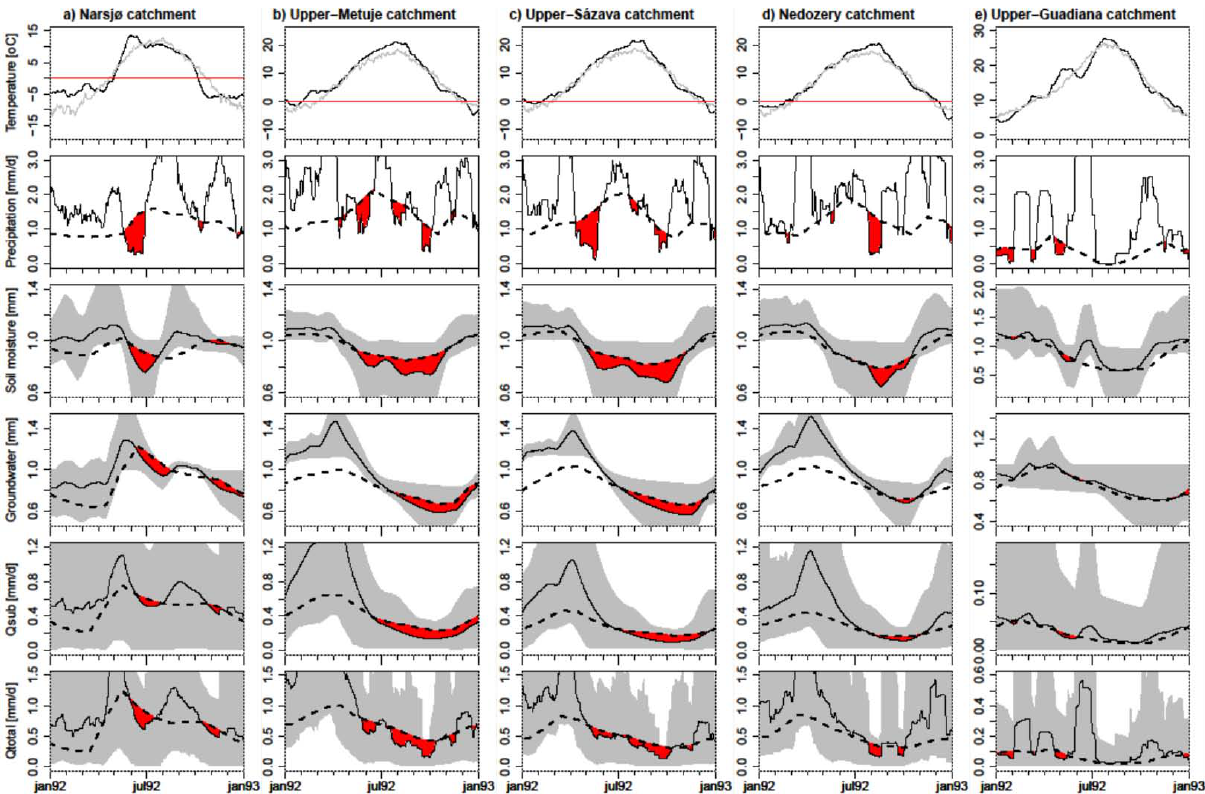
Fig. 4. Example of drought events in all case study areas, Narsjø, Upper-Metuje, Upper-S´azava, Nedoˇzery, and Upper-Guadiana in 1992 (legend: see Fig.